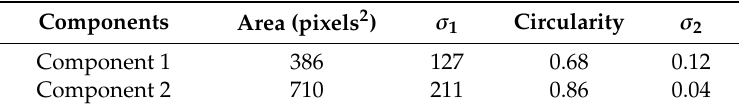
Table 1. Statistical values of the two components. Average area ± σ 1 and circularity ± σ 2 of E. coli bacteria by using the mixture of regression